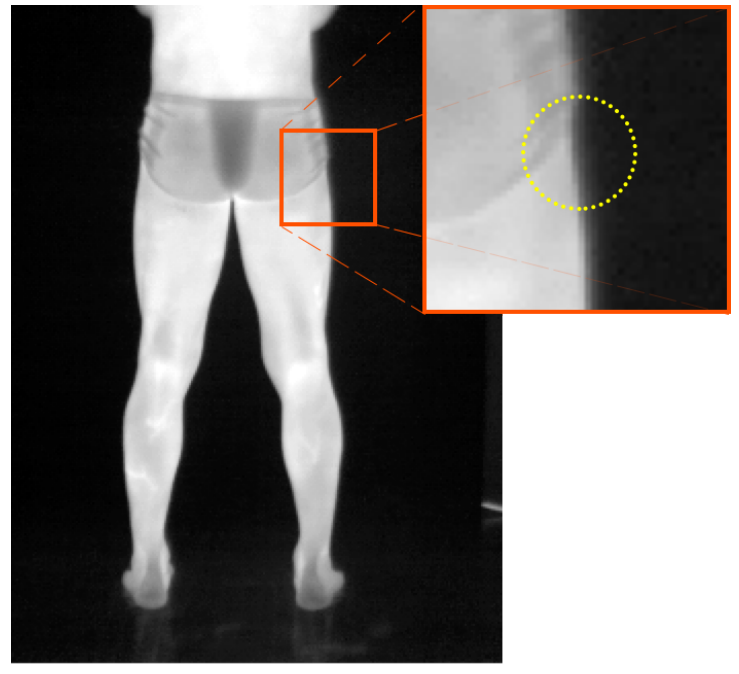
Figure 10. The fading effect of the intensity levels of the radiometric image near the edges of the human subject, due to the surface curvature. This is an expected concern in thermal imaging, and its counter-effects can be disregarded in this application.